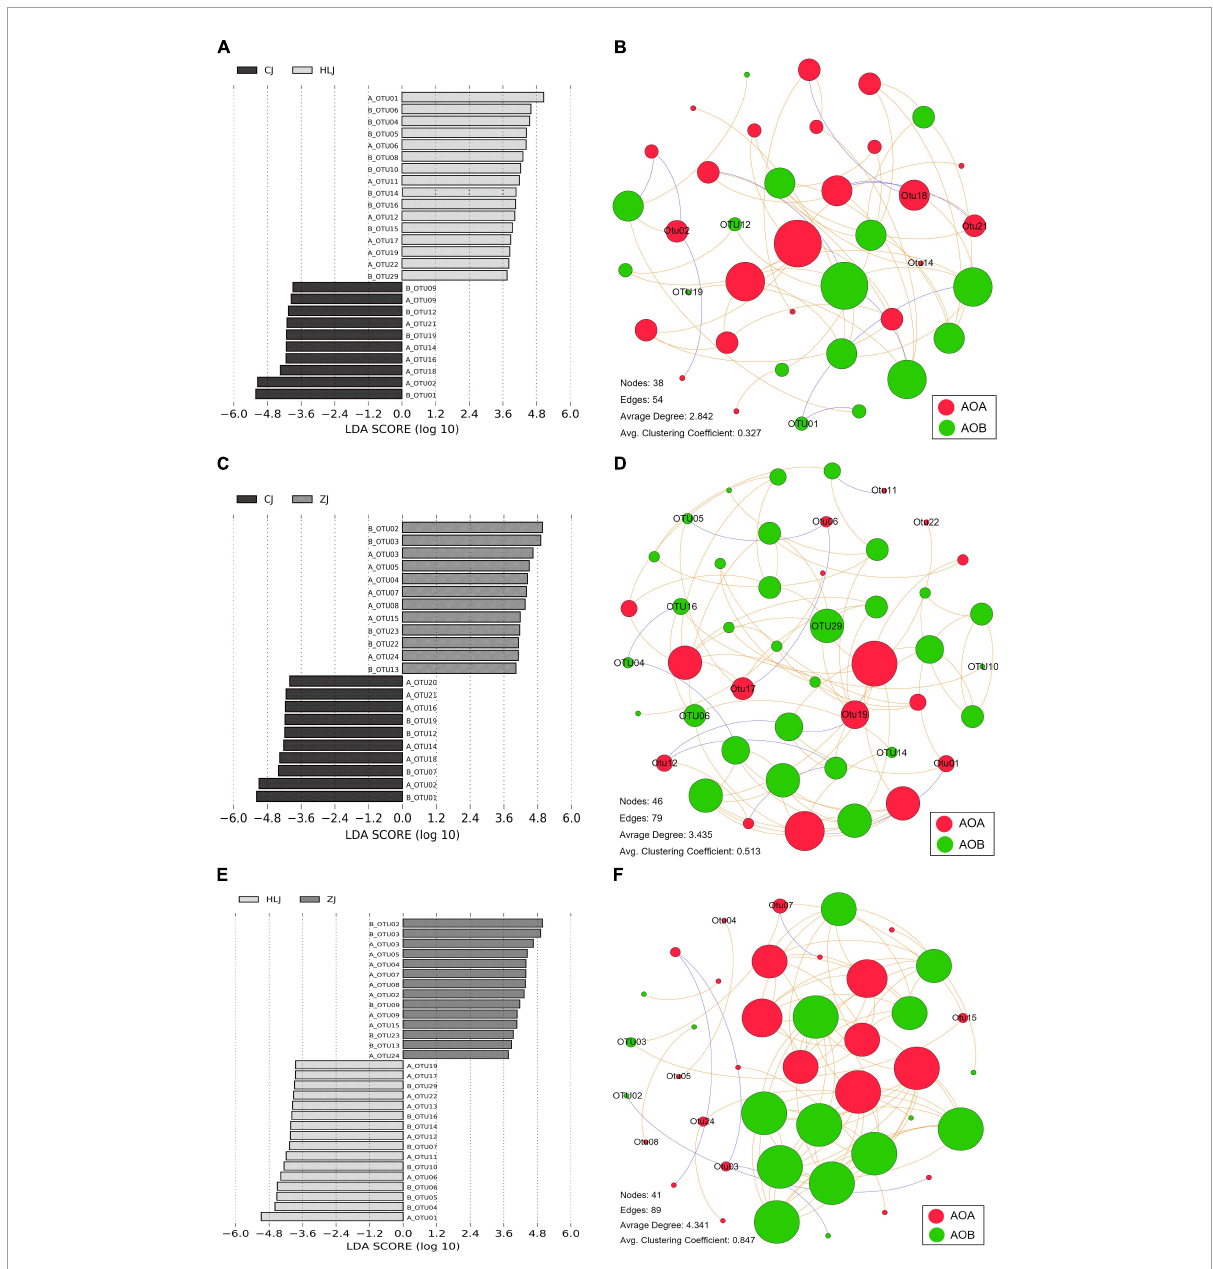
FIGURE4 Histogram of linear discriminant analysis scores computed for differentially abundant ammonia-oxidizing archaea (AOA) and ammonia-oxidizing bacteria (AOB) operational taxonomic units (OTUs) (A,C , E) , and their co-occurrence networks in different sampling areas ( B , D , F, representing CJ, HLJ, and ZJ areas, respectively). A_ and B_ represent AOA and AOB OTUs, respectively. OTUs with alpha values for the factorial Kruskal-Wallis test of less than 0.05, and LDA scores > 2.0, are shown. Nodes of different colors indicate different microbial communities, and the sizes are proportional to the connection numbers. Edges indicate correlations between different nodes, with the positive and negative correlations represented in red and green colors, respectively. Only the differentially abundant OTUs in different areas are